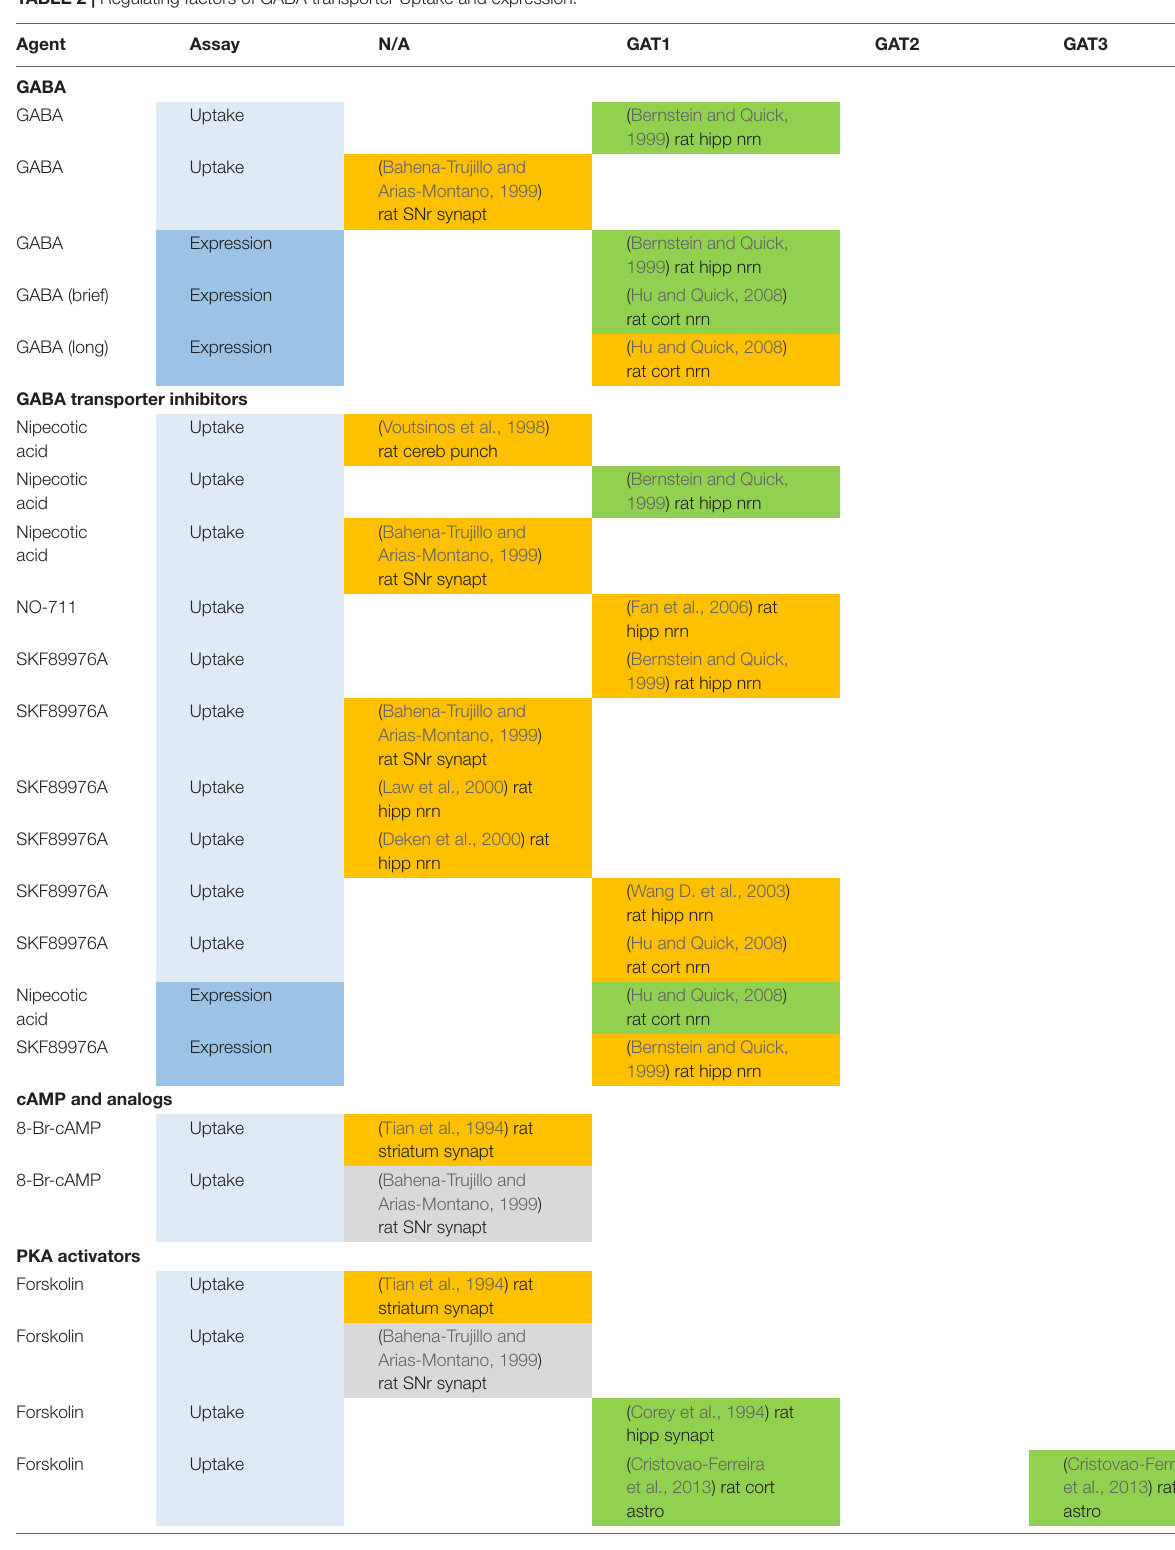
TABLE 2 | Regulating factors of GABA transporter Uptake and expression. Agent